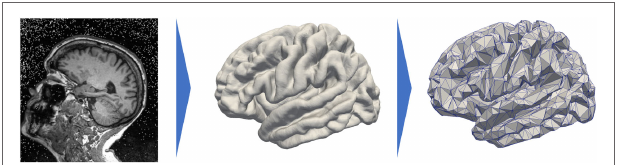
FIGURE 1 | Data preprocessing that projects the cortical thickness of the raw MRI observation (left) on a mesh, namely, the FSAverage atlas constituted of 163.842 nodes per hemisphere (middle) before subsampling it and averaging the signal onto a 1,827-node graph (right).